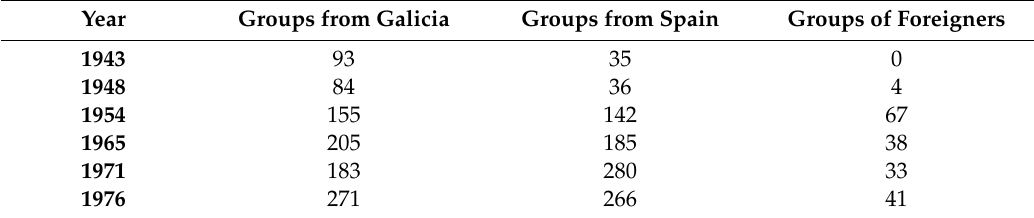
Table 3. Origin of groups of pilgrims reaching the city of Santiago in the Holy Years. Source: Data reported by Rodr í guez (2004) based on the analysis of the O ffi cial Journal of the Archdiocese, press, and other publications. Year Groups from Galicia Groups from